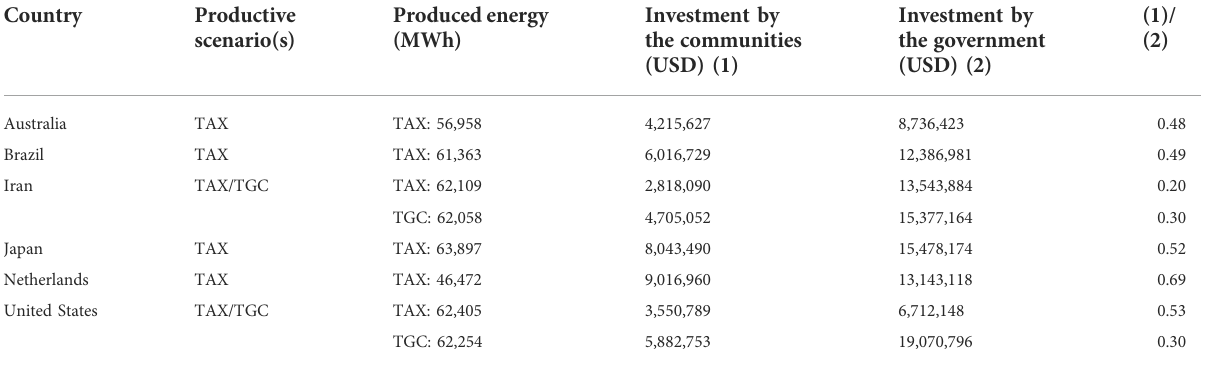
TABLE 11 Cost composition of the incentive